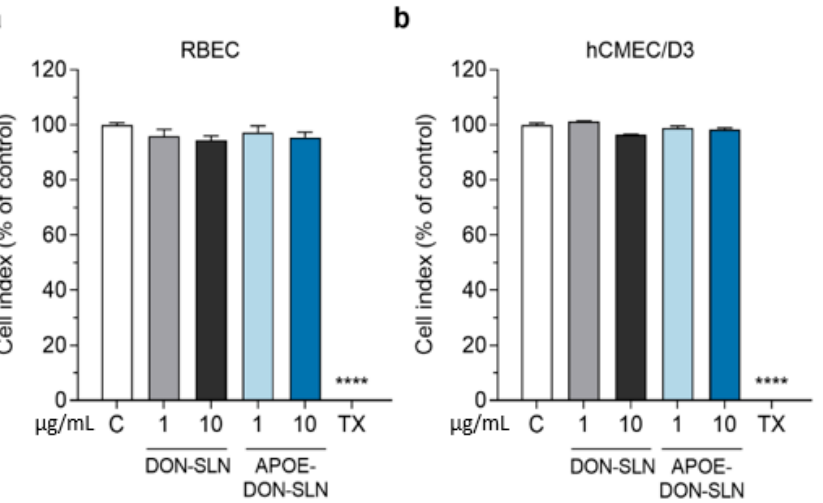
Figure 5. Effect of non-targeted (DON-SLN) and ApoE-targeted SLNs (APOE-DON-SLN) on the viability of ( a ) primary rat brain endothelial cells (RBEC) and ( b ) the human brain endothelial cell line hCMEC/D3 after 2 h of incubation, monitored by impedance measurement. Values presented are means ± SEM and are given as a percentage of control. Statistical analysis: one-way ANOVA followed by Dunnett’s posttest; **** p < 0.0001 compared to the control group; n = 6–8. C: culture medium-treated control group; TX: Triton X-100 treated cells, indicating maximal cellular toxicity.